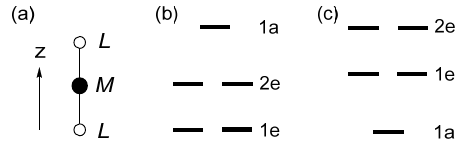
Figure 5. ( a ) Linear ML 2 molecule, where M is a transition metal, and L a main group ligand. ( b ) The d-state split pattern of 1e < 2e < 1a, predicted by the crystal-field theory (CFT). ( c ) The d-state split pattern of 1a < 1e < 2e assumed to rationalize the uniaxial magnetism of (Fe L 2 ) - and Co L 2 .